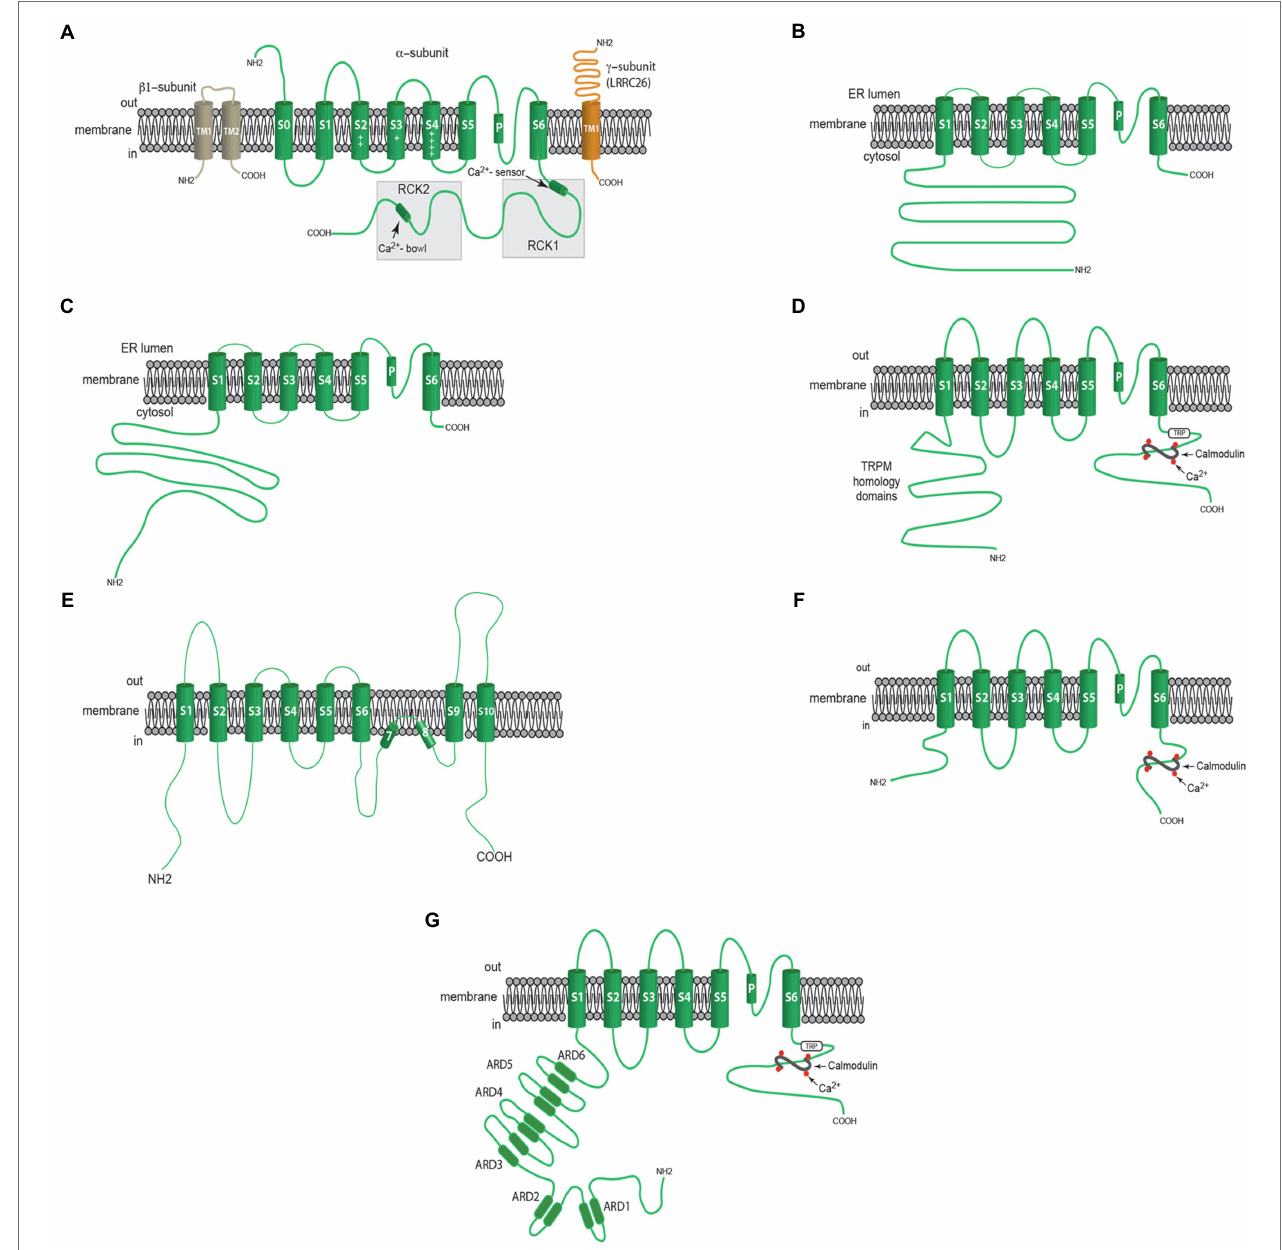
FIGURE 2 | Membrane topology of Ca 2+ -dependent ion channels involved in the regulation of myogenic tone. (A) Components of VSMC BK Ca channels including a β 1 - subunit with two membrane-spanning domains, one pore-forming α -subunit with seven membrane-spanning domains and a γ -subunit (LRRC26, for example) with one membrane-spanning domain. (B) Shows one α -subunit of an RYR with a large cytosolic N-terminal domain, 6 membrane spanning domains and a short C-terminal sequence. (C) Shows one α -subunit of an IP 3 R with a large cytosolic N-terminal domain, 6 membrane spanning domains and a short C-terminal sequence. (D) Shows one α -subunit of a TRPM4 channel including an N-Terminal domain with a TRPM homology sequence, 6 membrane spanning domains, and a C-terminal domain containing a TRP sequence and binding sites for calmodulin. (E) Shows one α -subunit of ANO1 (TMEM16A) CaCC with 10 membrane spanning domains. (F) Shows α -subunit of either sK Ca or IK Ca channels with 6 membrane spanning domains and a C-terminal domain with bindings sites for calmodulin. (G) Shows one α -subunit of a TRPV4 channel with N-terminal sequence containing ankyrin repeat domains (ARDs), 6 membrane spanning domains and a C-terminal domain with TRP sequence and calmodulin binding sites. See text for more